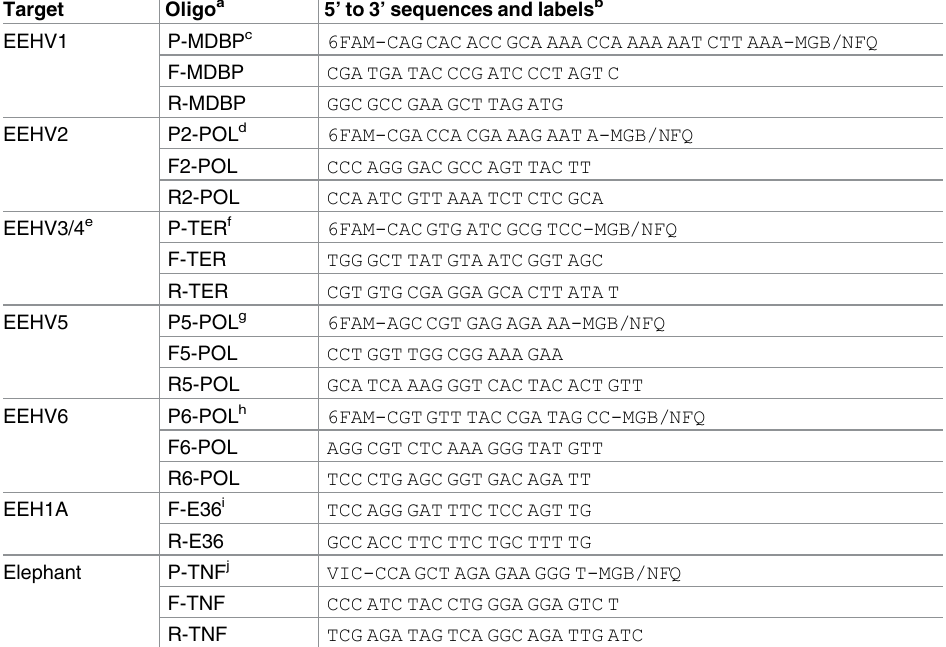
Table 2. Primers and probes used in this